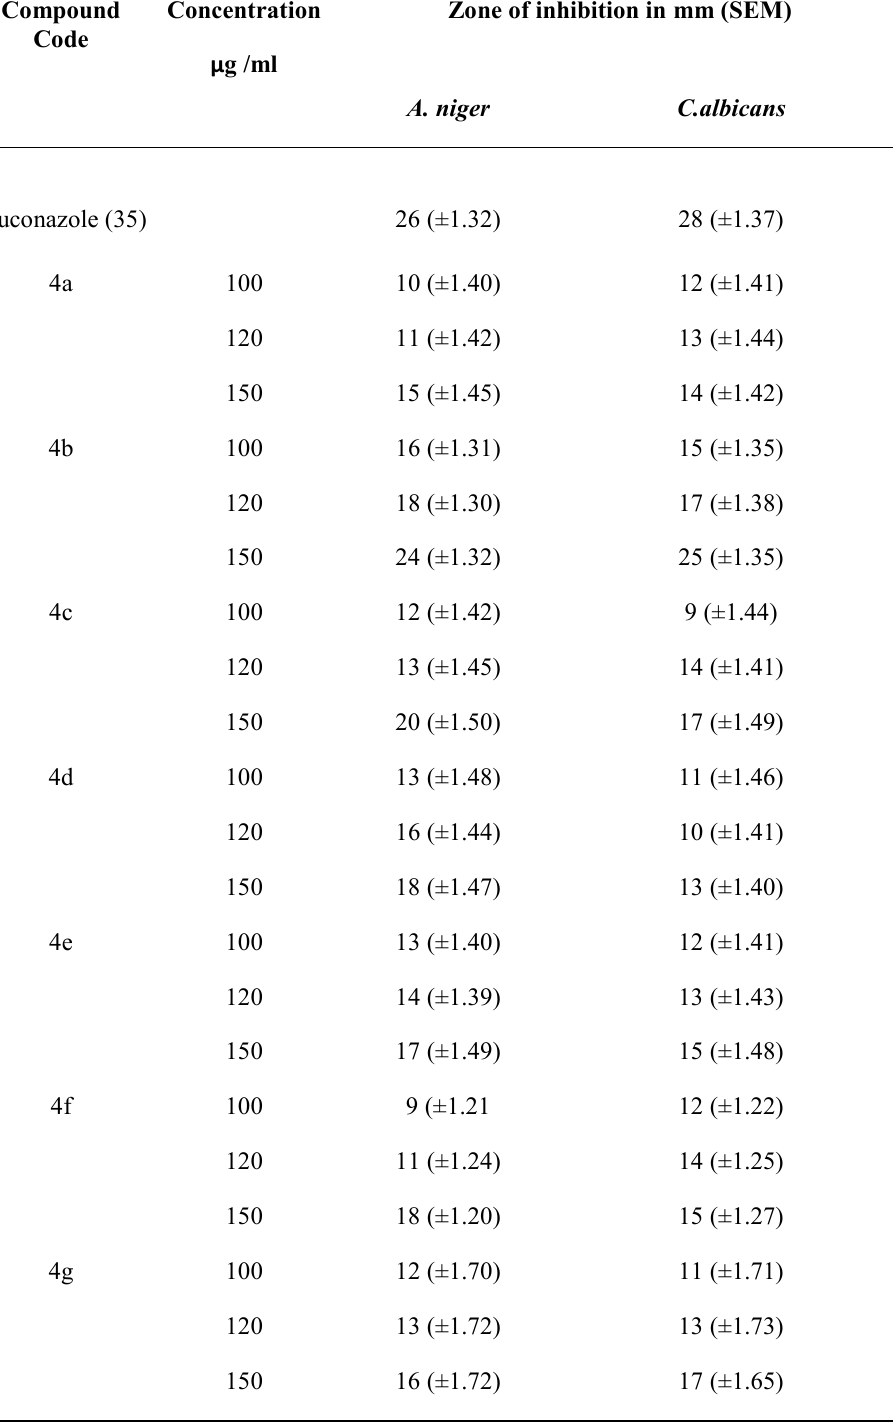
Table IV: Zone of inhibition of synthesized compounds against